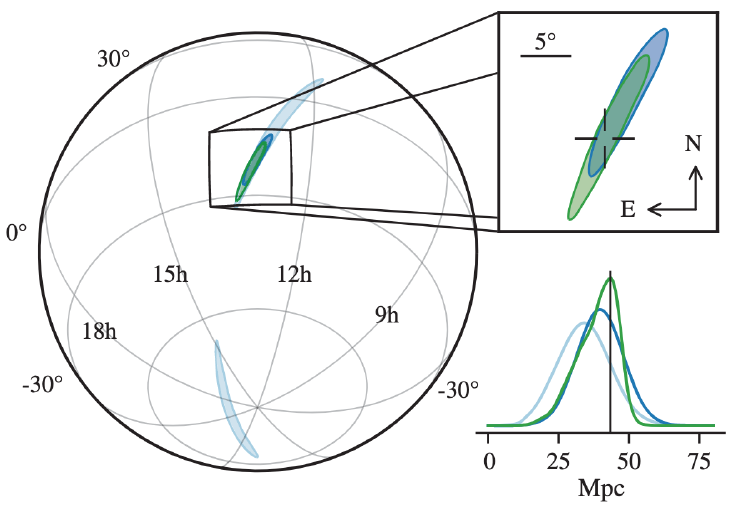
Figure 12. Sky location reconstructed for GW170817 by a rapid localization algorithm from a two- detector (LIGO Hanford and LIGO Livingston, 190 deg 2 , light blue contours) and a three-detector (LIGO Hanford, LIGO Livingston and Virgo, 31 deg 2 , dark blue contours) analysis. A higher latency three-detector analysis improved the localization (28 deg 2 , green contours). In the top-right inset panel, the reticle marks the position of the host galaxy NGC 4993. The bottom-right panel shows the a posteriori luminosity distance distribution from the three gravitational-wave localization analyses. The distance of NGC 4993 is shown with a vertical line. Figure from [85]: © The Authors, published by the American Physical Society. This is an open access article distributed under the terms of the Creative Commons Attribution License 4.0 (http://creativecommons.org/licenses/by/4.0/ (accessed on 10 August